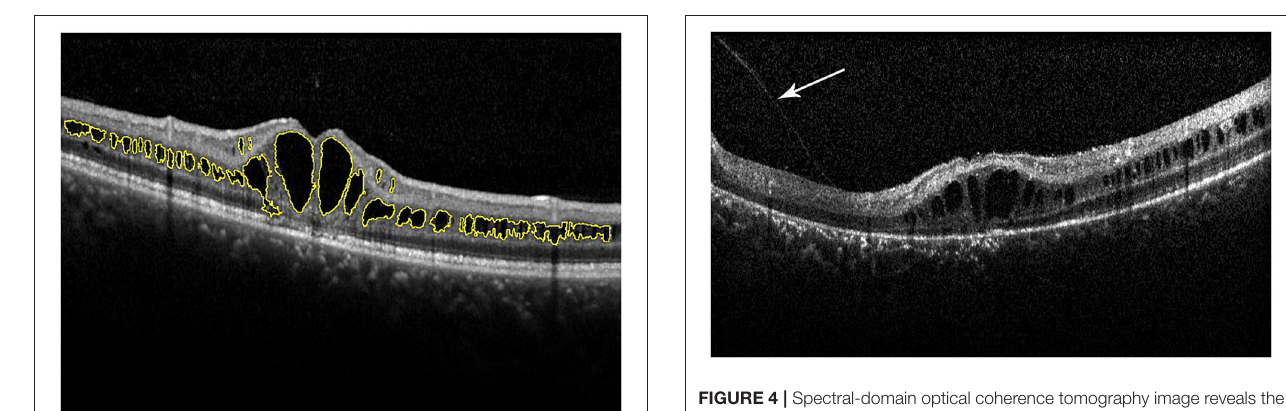
FIGURE 4 | Spectral-domain optical coherence tomography image reveals the vitreomacular adhesion (VMA) in the macula (white arrow), with loss of outer retinal layers, and a minimal attenuation of RPE band. But the patient did not have macular atrophy visible in the fundus photograph. 0.90 (0.70–1.00) logMAR, and 33 (84.6%) patients had